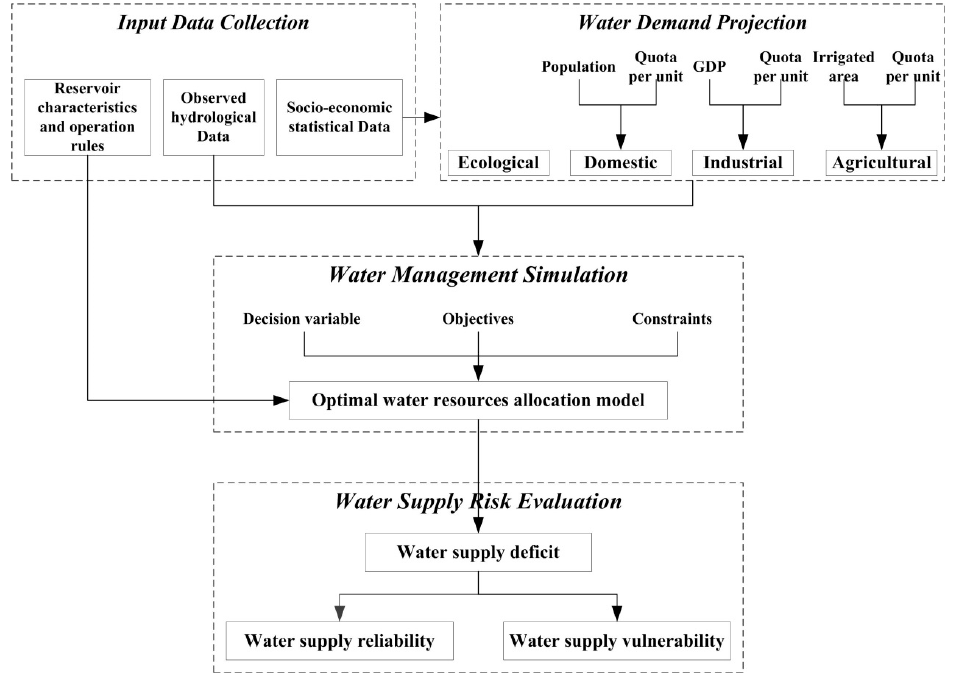
Figure 3. Structure of the integrated water resources management model.